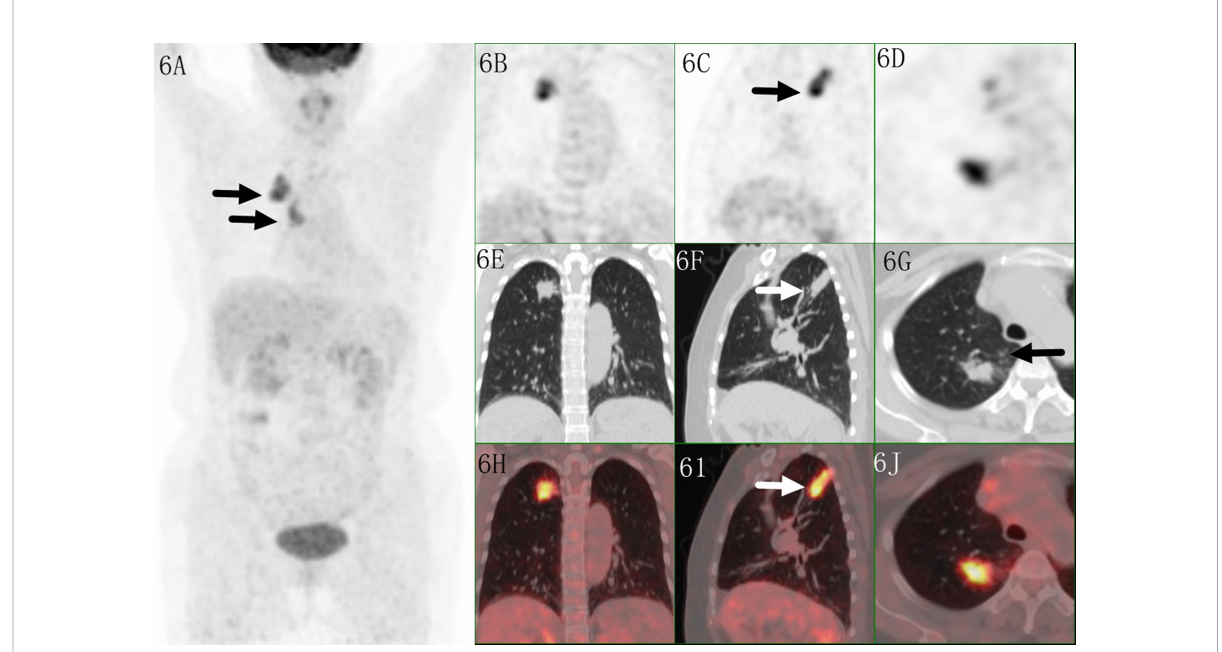
FIGURE 6 Images of a 61-year-old female patient with tuberculosis. PET MIP (A) showed a mass in the right upper lobe with mediastinal lymph node. The irregular lesion located in peripheral site, with a SUVmax of 8.9 on coronal/saggital/trans axial PET (B – D) , CT (E – G) and fused (H – J) images. Higher uptake was seen in the proximal region which indicated malignant lesion, but irregular shape with multiple small satellite nodules indicated